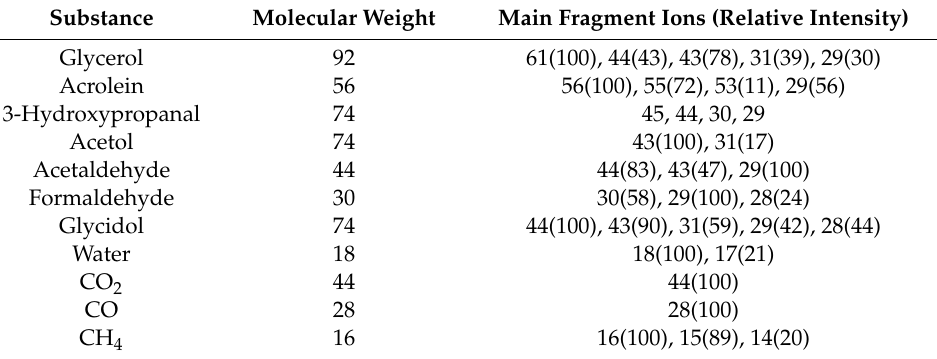
Figure 2. A typical mass spectrometry profile of acrolein in TPSR of glycerol absorbed SAPO-11. Table 1. The main fragment ions of the products from glycerol